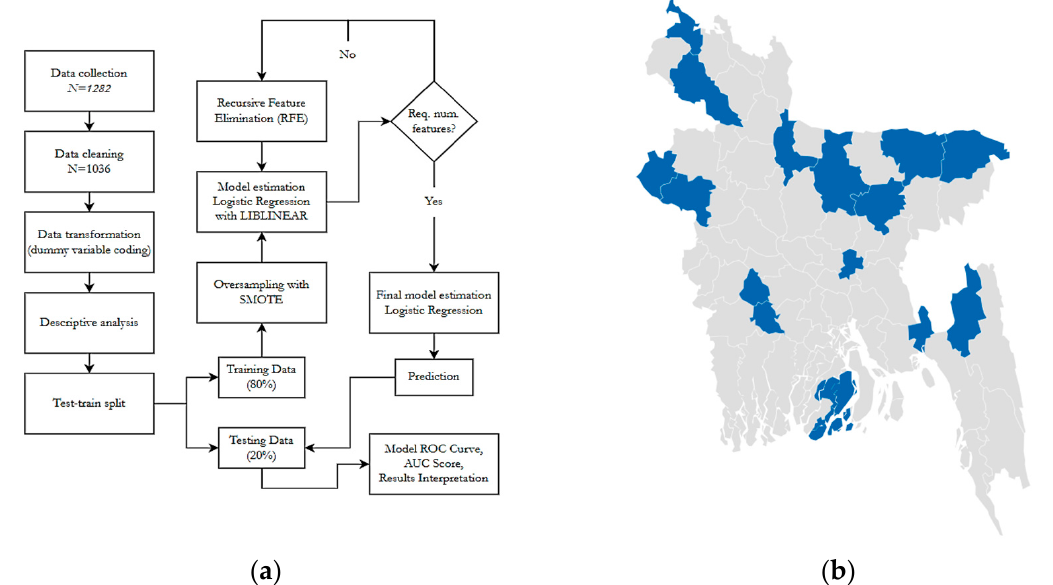
Figure 1. ( a ) Flow diagram of the current research; ( b ) Choropleth map of selected districts in the current sample.